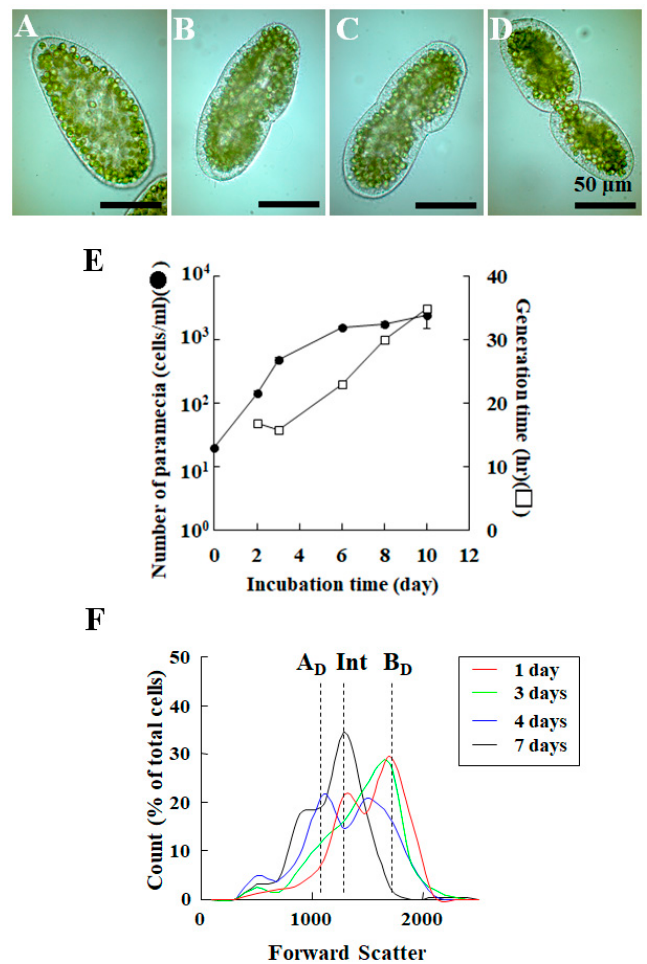
Figure 5. Growth dynamics of P. bursaria host cells and its detection using capillary FCM. ( A – D ) Micrographs of P. bursaria at interphase and division phase are shown. ( E ) Chronologic population dynamics of P. bursaria host cells (black circle) were tracked over time. The generation time (white circle) estimated from the number of P. bursaria is also shown. ( F ) Data obtained with P. bursaria are shown as forward scatter signals (FSS) vs. count (% of total signals for intact P. bursaria cells). As described in the literature [7], dotted lines in panel F display each discernible peak size of P. bursaria . Each dotted line respectively shows the group of small Paramecium cells shortly after Paramecium cell division (A D ), that of cells in the process of cytokinesis (B D ), and those of the intermediary cell sizes at both the interphase and in the process of karyokinesis (Int). Panels ( A – F ) were referred from the literature [7].